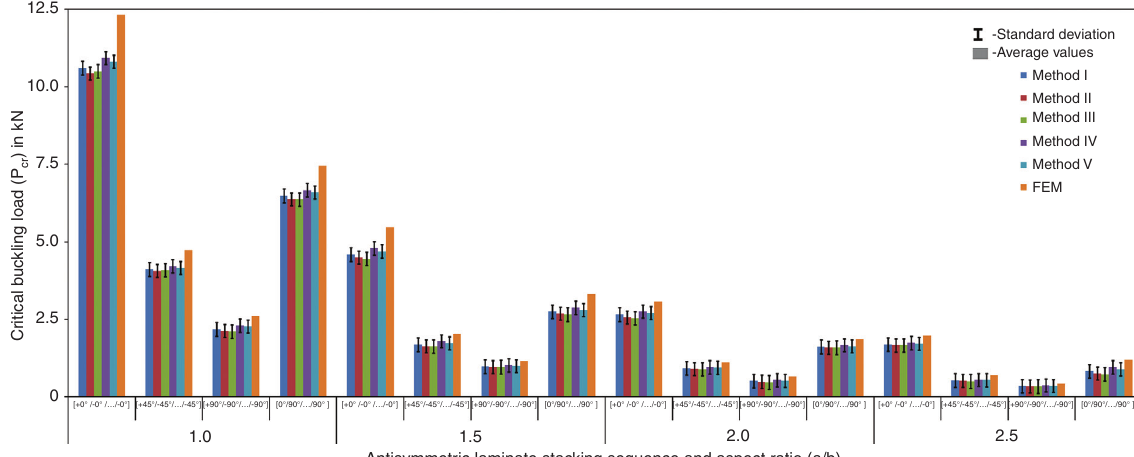
Figure 8 Critical buckling load for laminated skew plate ( α = 15 ° ).